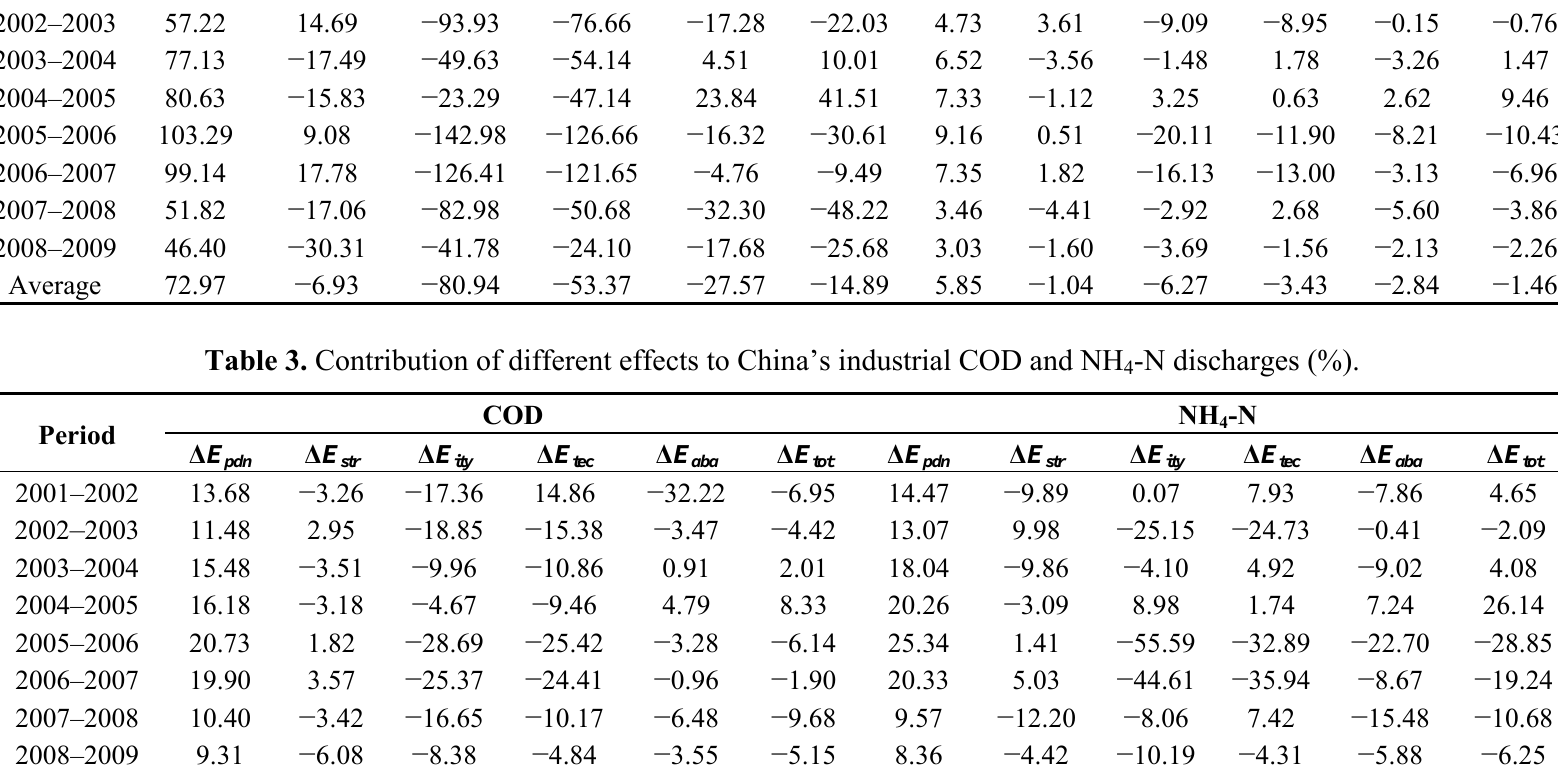
Table 2. Contribution of different effects to China’s industrial COD and NH Period